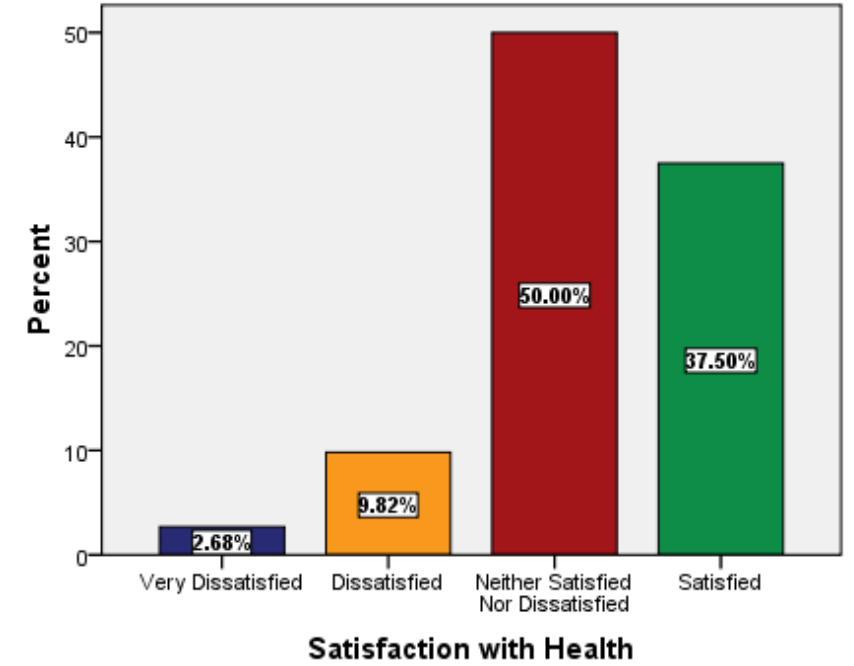
Figure 2. Descriptive statistics of overall satisfaction with health.